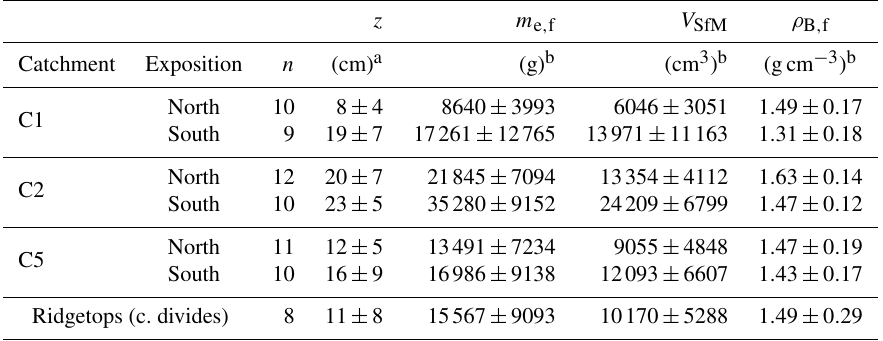
Table 7. Average values derived for the soil depth ( z ) and photogrammetry-based field-state bulk density ( ρ B , f ) determination of the AT17–18 sampling